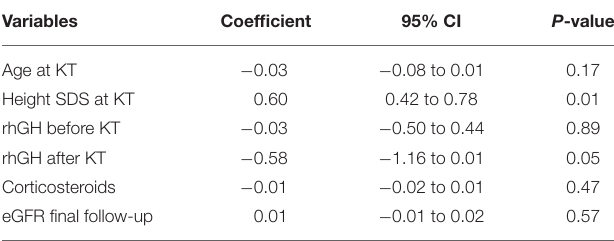
TABLE 4 | Multivariate regression analysis for factors influencing SDS final